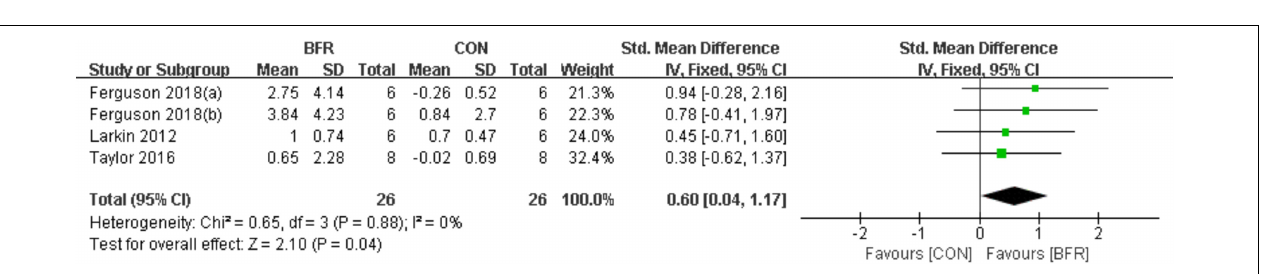
FIGURE 5 | The forest plot of the effect size for studies assessing the effect of blood flow restriction exercise on the eNOS